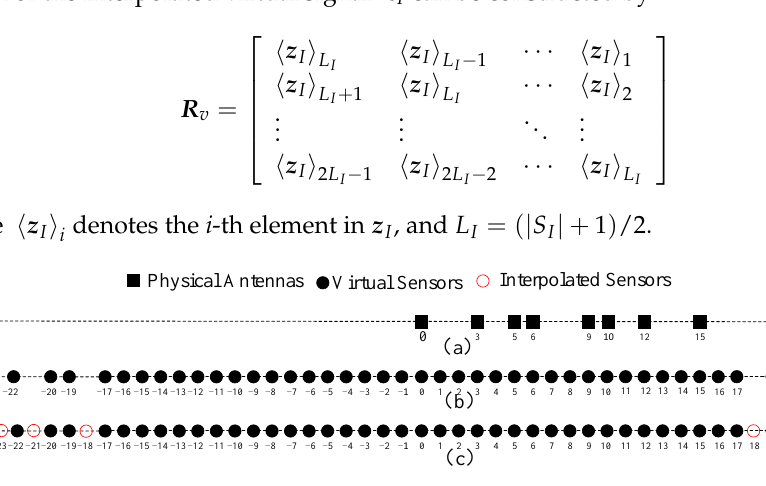
Figure 2. Various array representations are given with M 1 = 3 and M 2 = 5. ( a ) Extended coprime array; ( b ) virtual array S v ; ( c ) interpolated virtual array S I